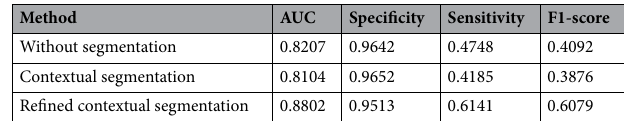
Table 2. Performance metrics for classification with dermnet images.